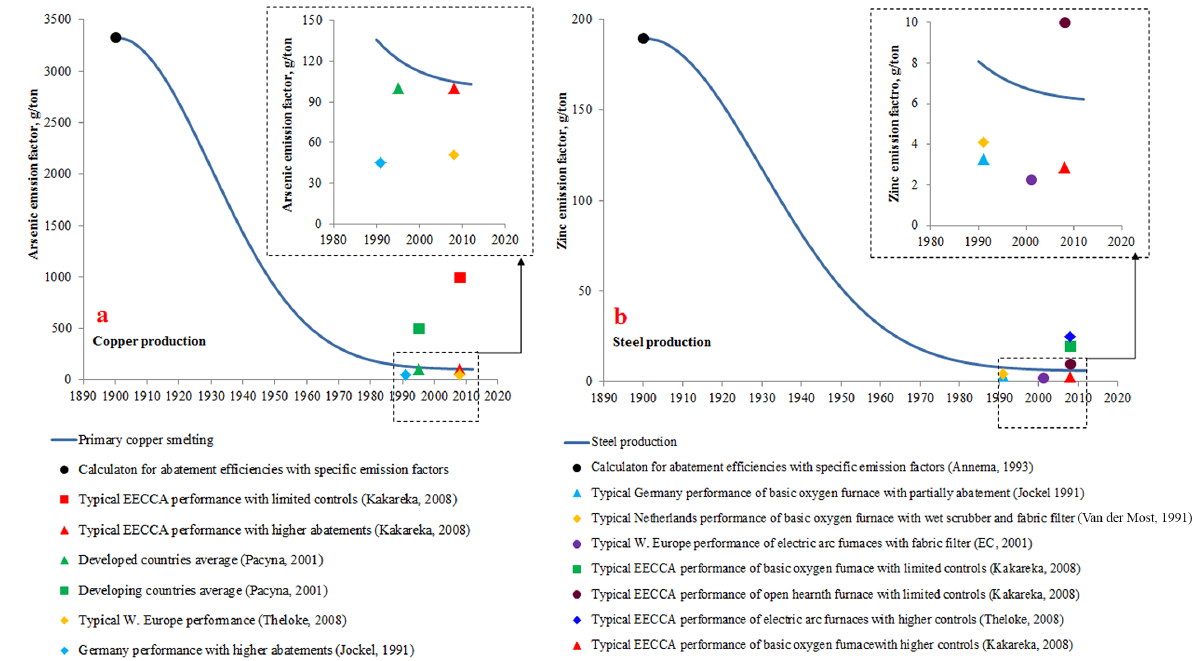
Figure 1. Time variation of arsenic emission factors for copper production and zinc emission factors for steel production in China (an